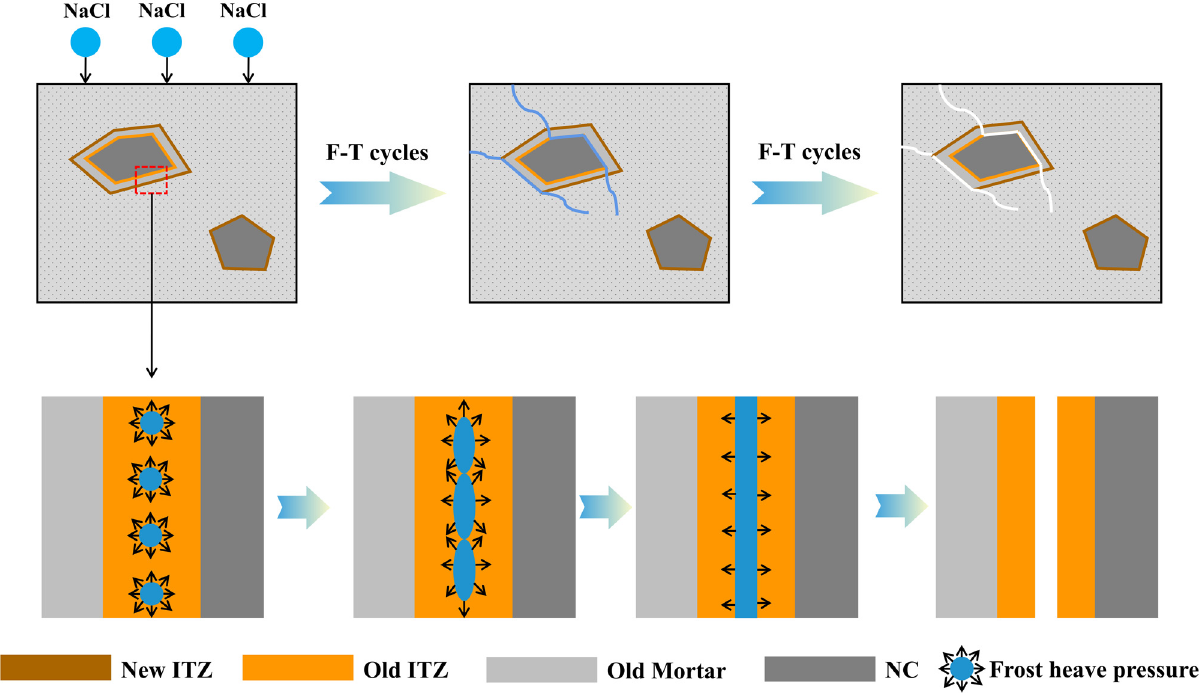
Figure 11: Damage mechanism of salt - frost cycles on